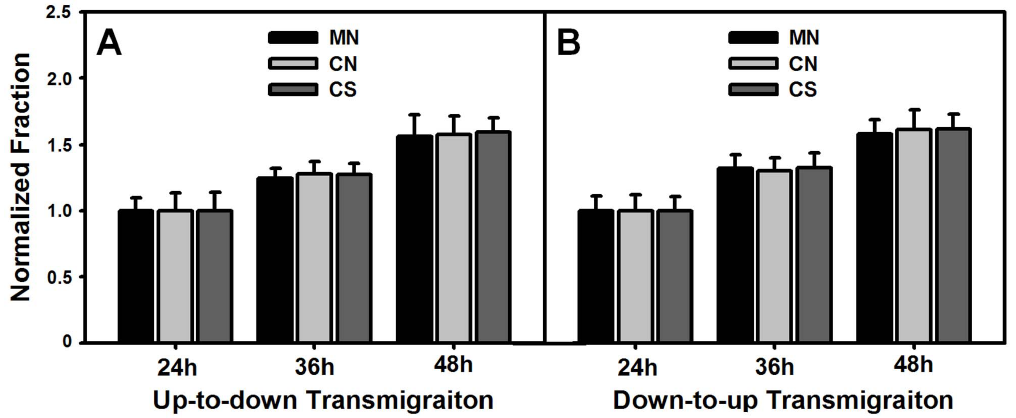
Figure 6. Transmigration of HF cells on collagen I-coated transwell chamber. Up-to-down ( A ) or down-to-up ( B ) transmigration of monoclutured or cocultured HF cells in the absence or presence of mechanical stretch. Data are presented as the fraction of transmigrated HaCaT cells at t =36, 48 h normalized to that at t =24 h in respective cases.